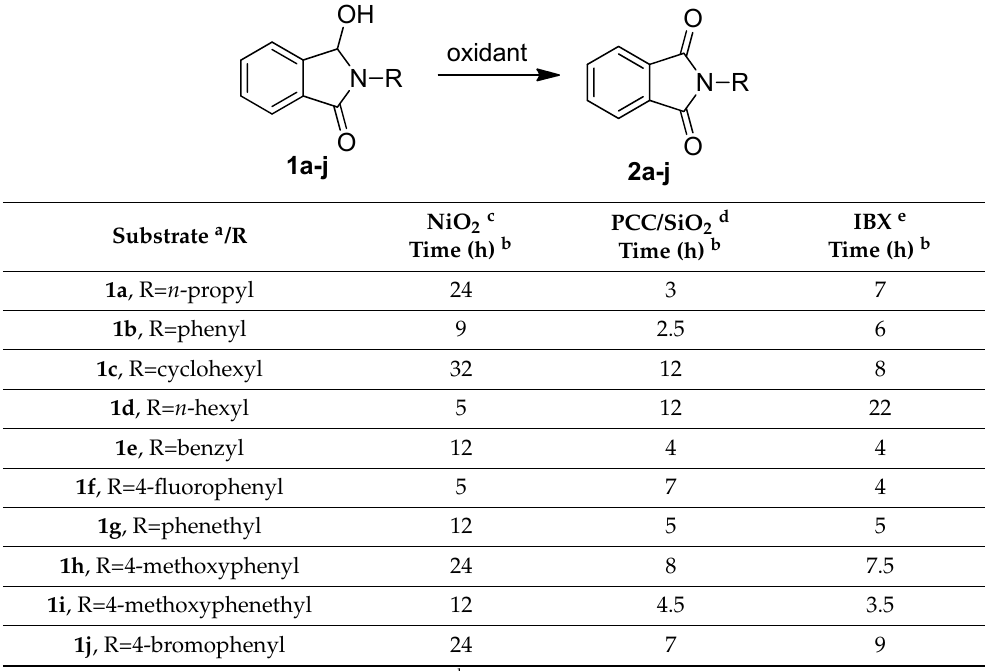
Table 1. Conversions of Hydroxylactams 1a–j to Imides 2a–j Using NiO 2 , PCC/Silica and IBX Reagents.